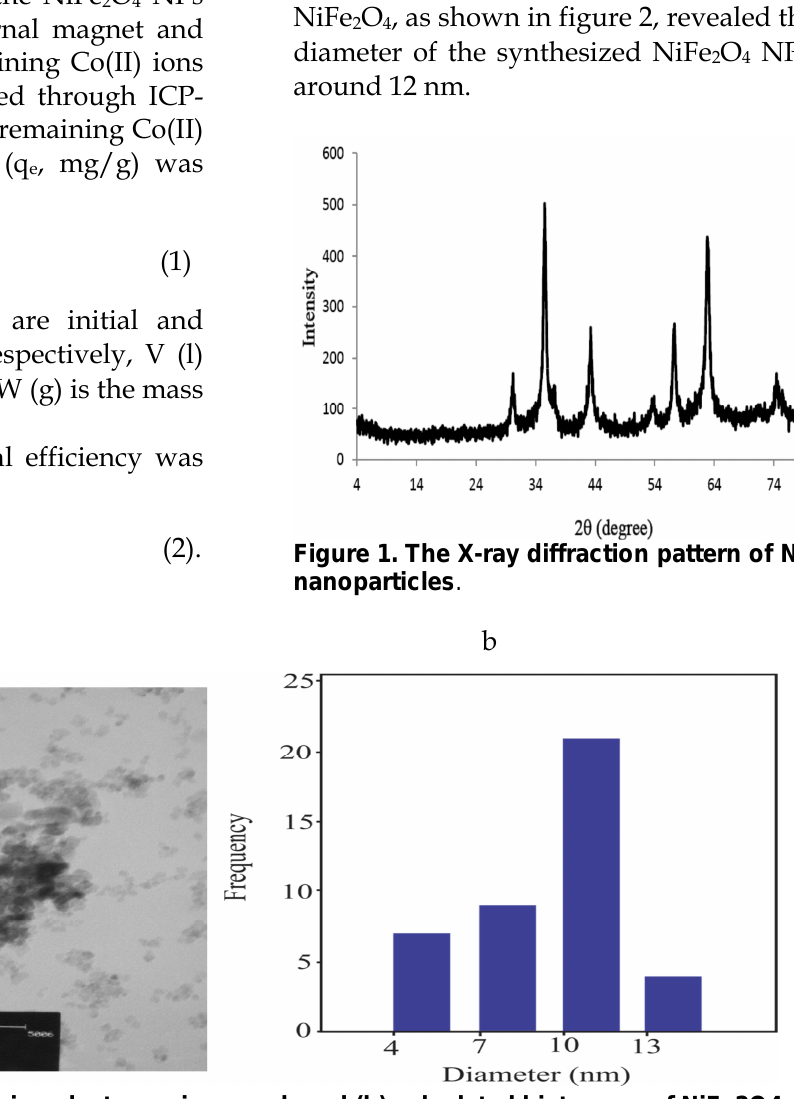
Figure 2. (a) Transmission electron micrograph and (b) calculated histogram of NiFe2O4 nanoparticles